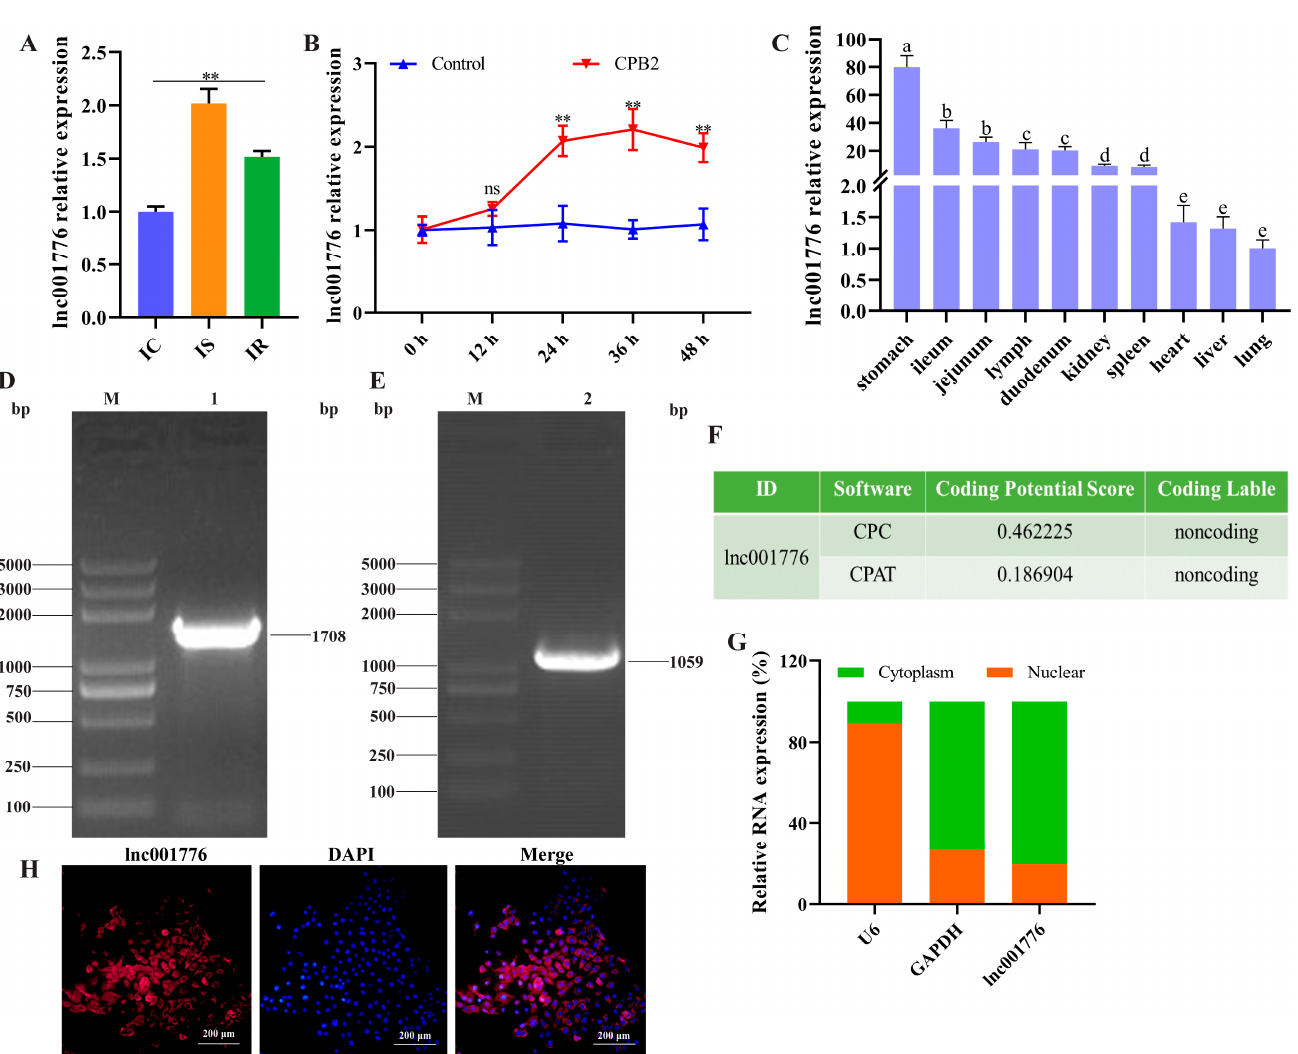
Figure 1. lnc001776 was elevated in CPB2 toxin-treated IPEC-J2 cells. ( A ) lnc001776 expression in IC, IS and IR groups by RT-qPCR. ( B ) lnc001776 expression in CPB2 toxin-infected IPEC-J2 cells by RT-qPCR. ( C ) lnc001776 levels in di ff erent tissues of healthy piglets via RT-qPCR. Di ff erent lowercase le tt ers indicate highly signi fi cant di ff erences between groups ( p < 0.01). ( D ) 5 ′ RACE PCR ampli fi cation. ( E ) 3 ′ RACE PCR ampli fi cation. ( F ) lnc001776 coding ability prediction by CpC2 and CPAT. ( G ) lnc001776 expression in IPEC-J2 cytoplasm and nucleus. ( H ) lnc001776 location in IPEC-J2 cells through RNA-FISH. M: 5000 DNA marker; 1: 5 ′ RACE ampli fi cation product; 2: 3 ′ RACE ampli fi cation product. ns: not signi fi cant. ** p < 0.01.